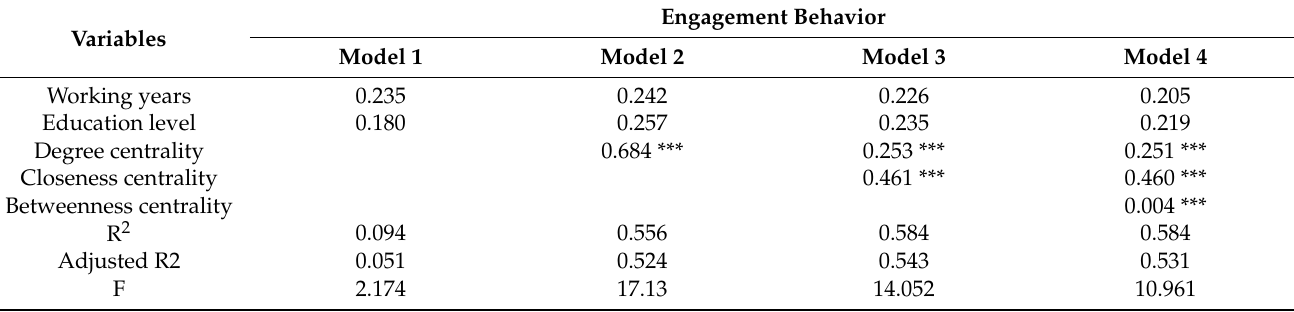
Table 7. Main effects test of